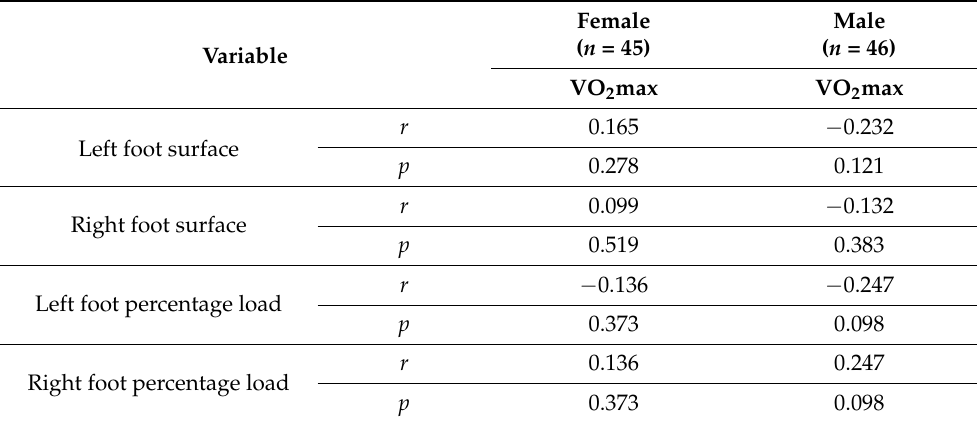
Table 5. Results of Pearson’s r correlation test examining relationships between maximal oxygen uptake and foot load